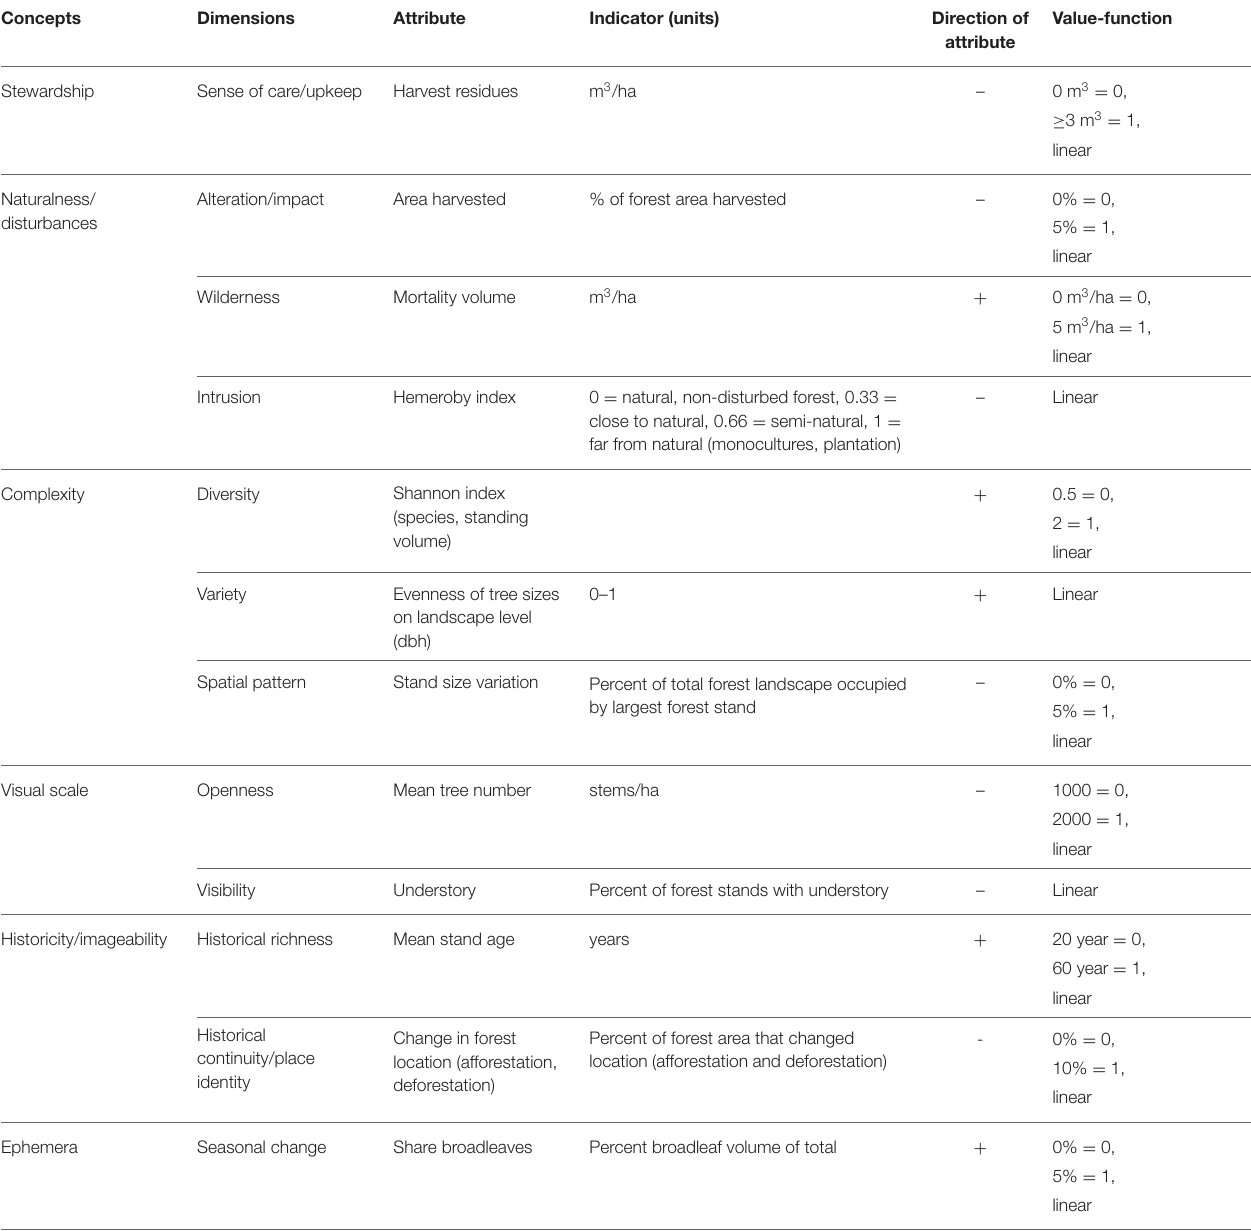
TABLE 1 | Overview of operationalisation of indicators and attributes for all dimensions and concepts, including the specific value functions to determine upper and lower limits before averaging the score to create the